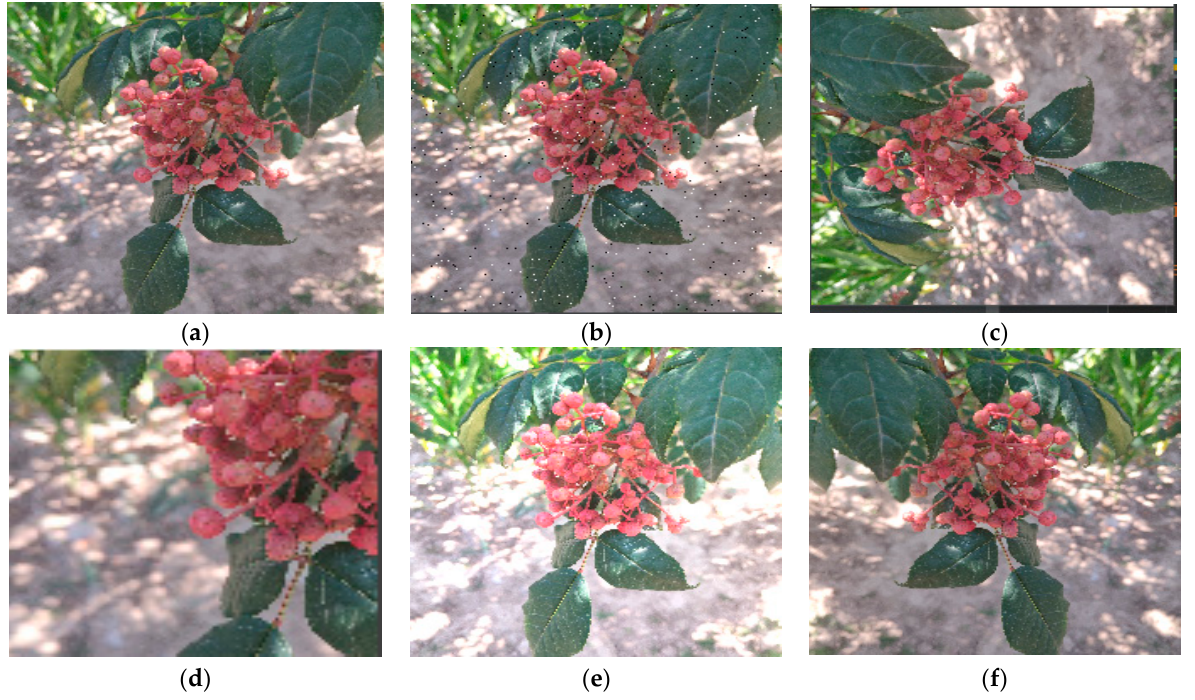
Figure 2. Image enhancement results. ( a ) Ripe Zanthoxylum string; ( b ) Increased noise result; ( c ) Rotation result; ( d ) Random clipping result; ( e ) Increased brightness result; ( f ) Mirror flip result.